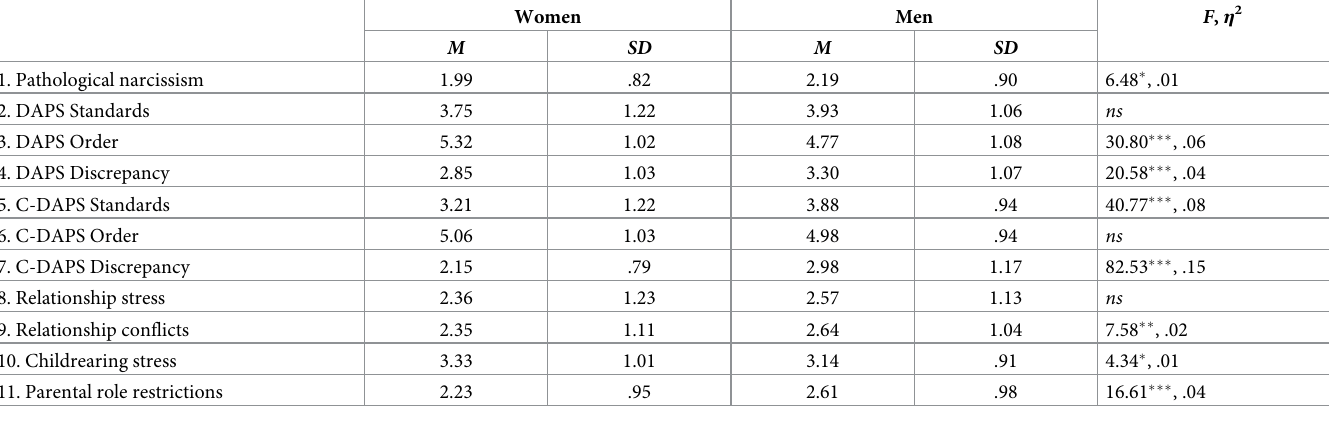
Table 3. Differences between women and men in respect of the analyzed